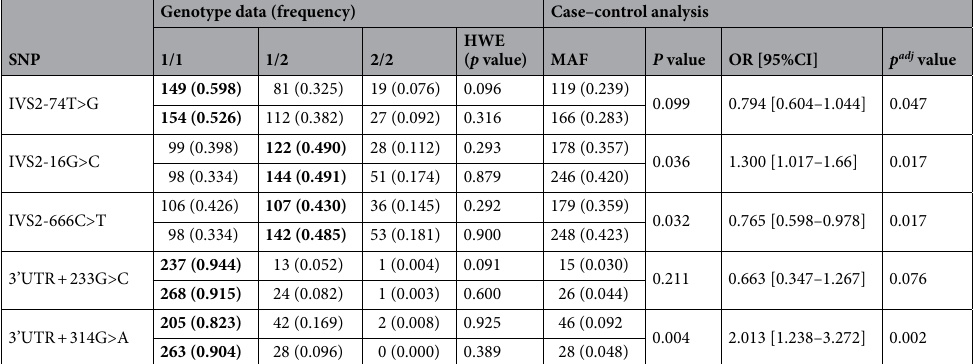
Table 1. Single association analysis of five tagging SNPs of the HBB gene with beta-thalassemia. Case data is at the top line, while control data is at the bottom line. The major allele is depicted as 1. Minor allele is represented as 2. MAF minor allele frequency. The p value < 0.05 is considered significant in Pearson Chi- Square. p adj -value is Bonferroni correction based on the five markers tested in this